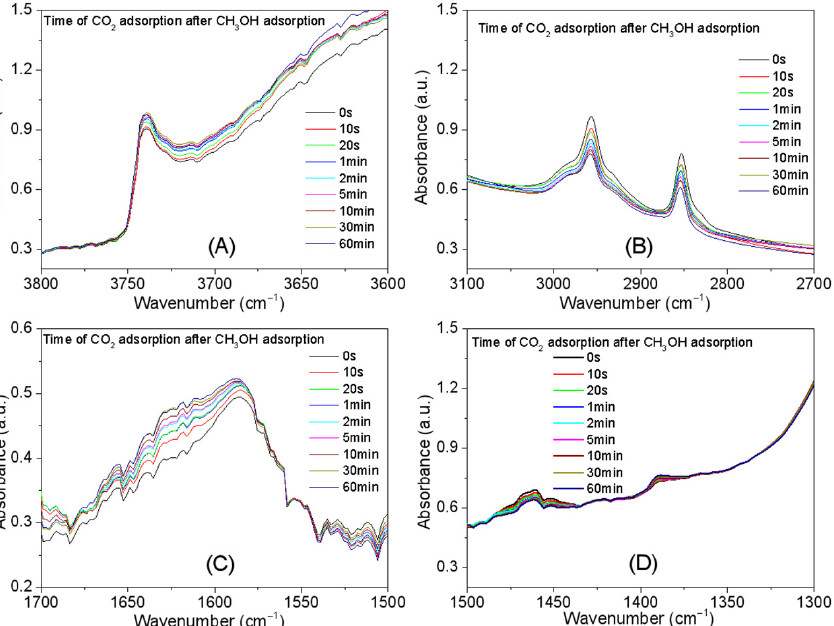
CH 3 OC(O)O-Zr(Si).